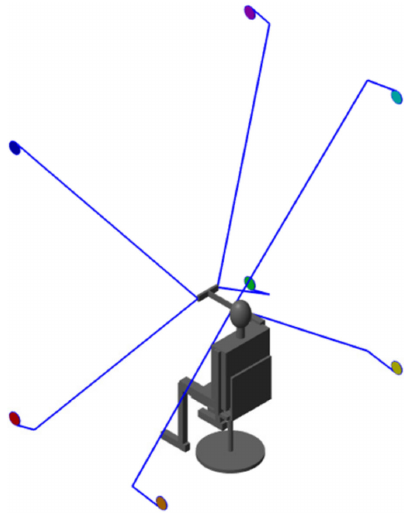
Figure 7. The PCUR simulation model